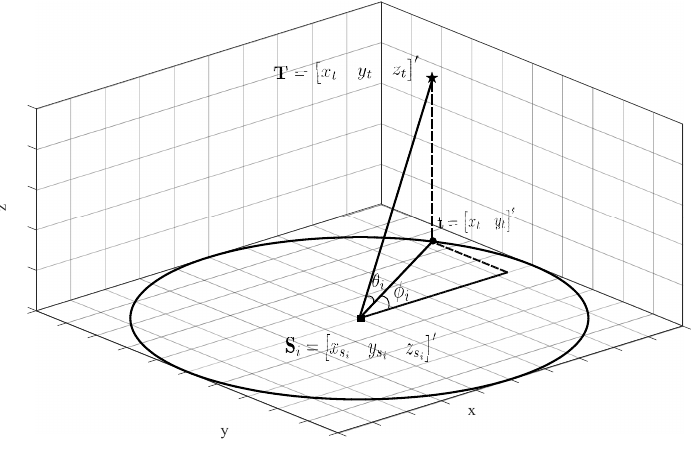
Figure 1. Target and sensor in R 3